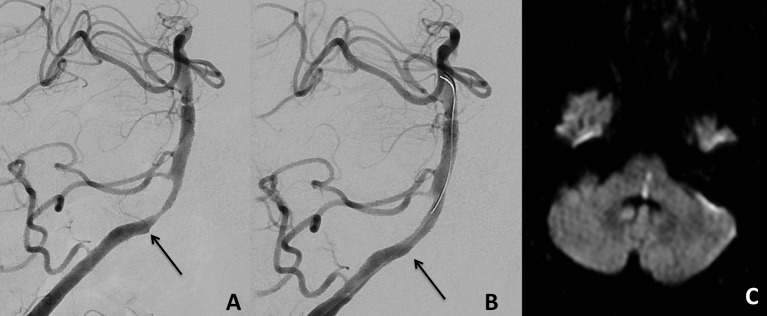
Proximal basilar artery stenosis before treatment (A) with the arrow indicating a perforating artery arising at the proximal part of the stenosis. Stent-PTA led to an occlusion of this perforating artery (B). MRI at day 1 after the procedure showed a left paramedian pontomedullary DWI lesion leading to a mRS score of 4 on follow-up examination after 6 months (C).